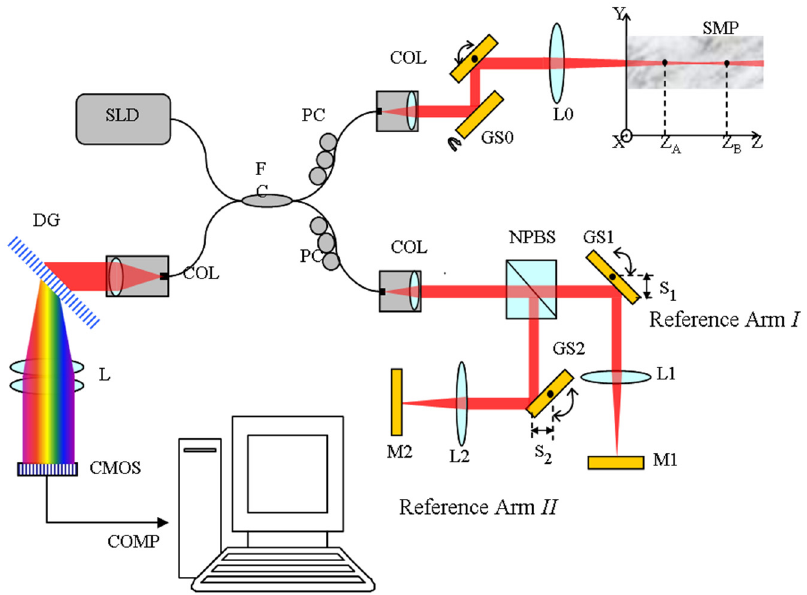
Figure 1. Schematic of the spatial frequency domain multiplexing spectral domain optical coherence tomography (SDOCT) system. SLD: super luminescent diode; FC: fiber coupler; NPBS: non-polarizing beam splitter; M: reference mirror; GS: galvanometer scanner; L: lens; SMP: sample; COL: collimator; PC: polarization controller; DG: diffraction grating; COMP: computer; CMOS: complementary metal oxide semiconductor.